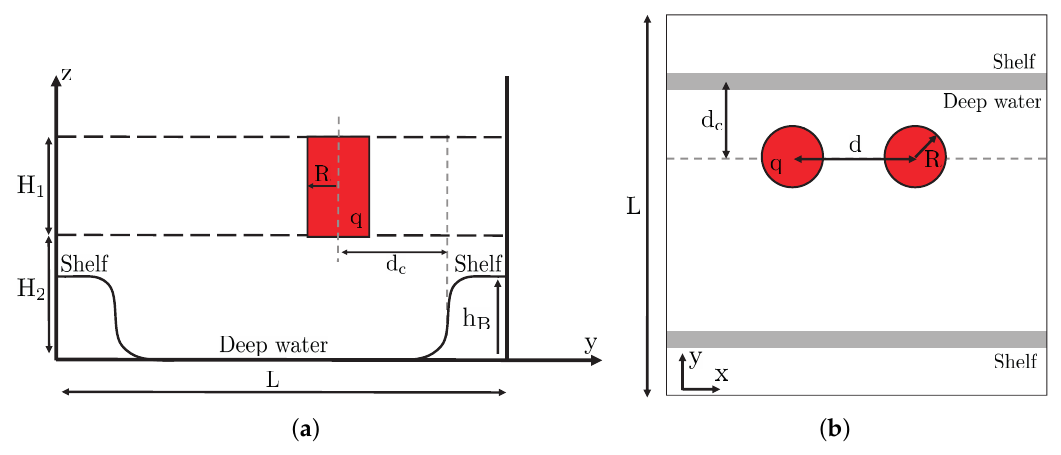
Figure 2. Sketch of model and vortex configuration; ( a ) side view; ( b ) top